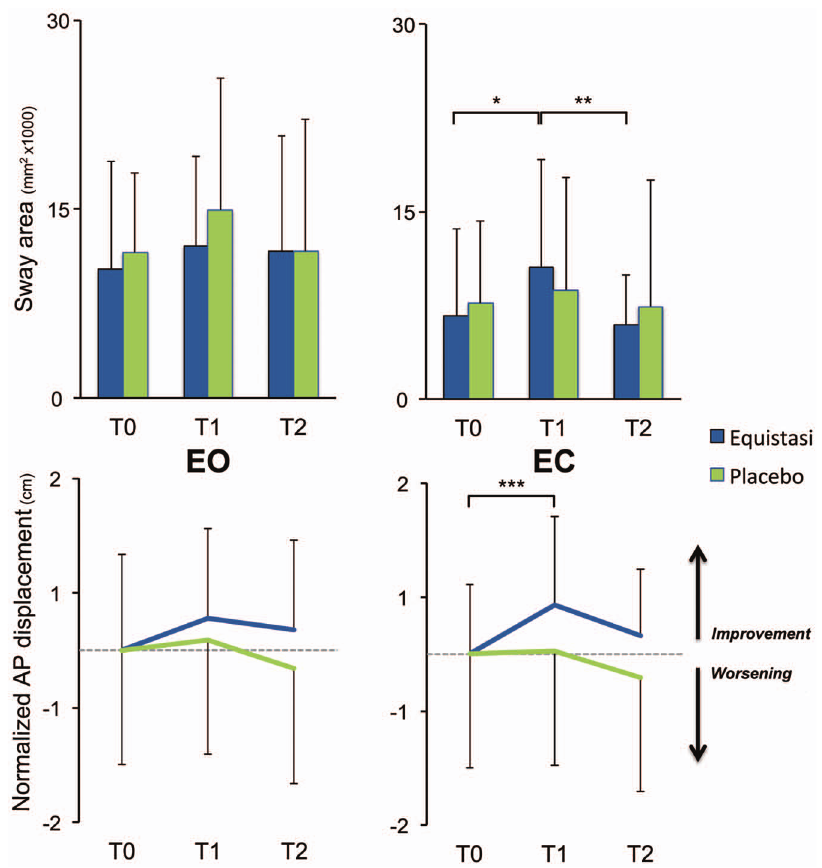
Figure 3. The sway area and the displacement along the AP axis (expressed as value normalized to the baseline) at the instrumental FRT during EO (left panels) and EC (right panels) conditions. Data are presented as mean 6 standard deviation. Abbreviations: AP: antero- posterior; EC: eyes closed; EO: eyes open; *: p=.006; **: p=.02; ***: p=.01 (Wilcoxon signed-rank test).